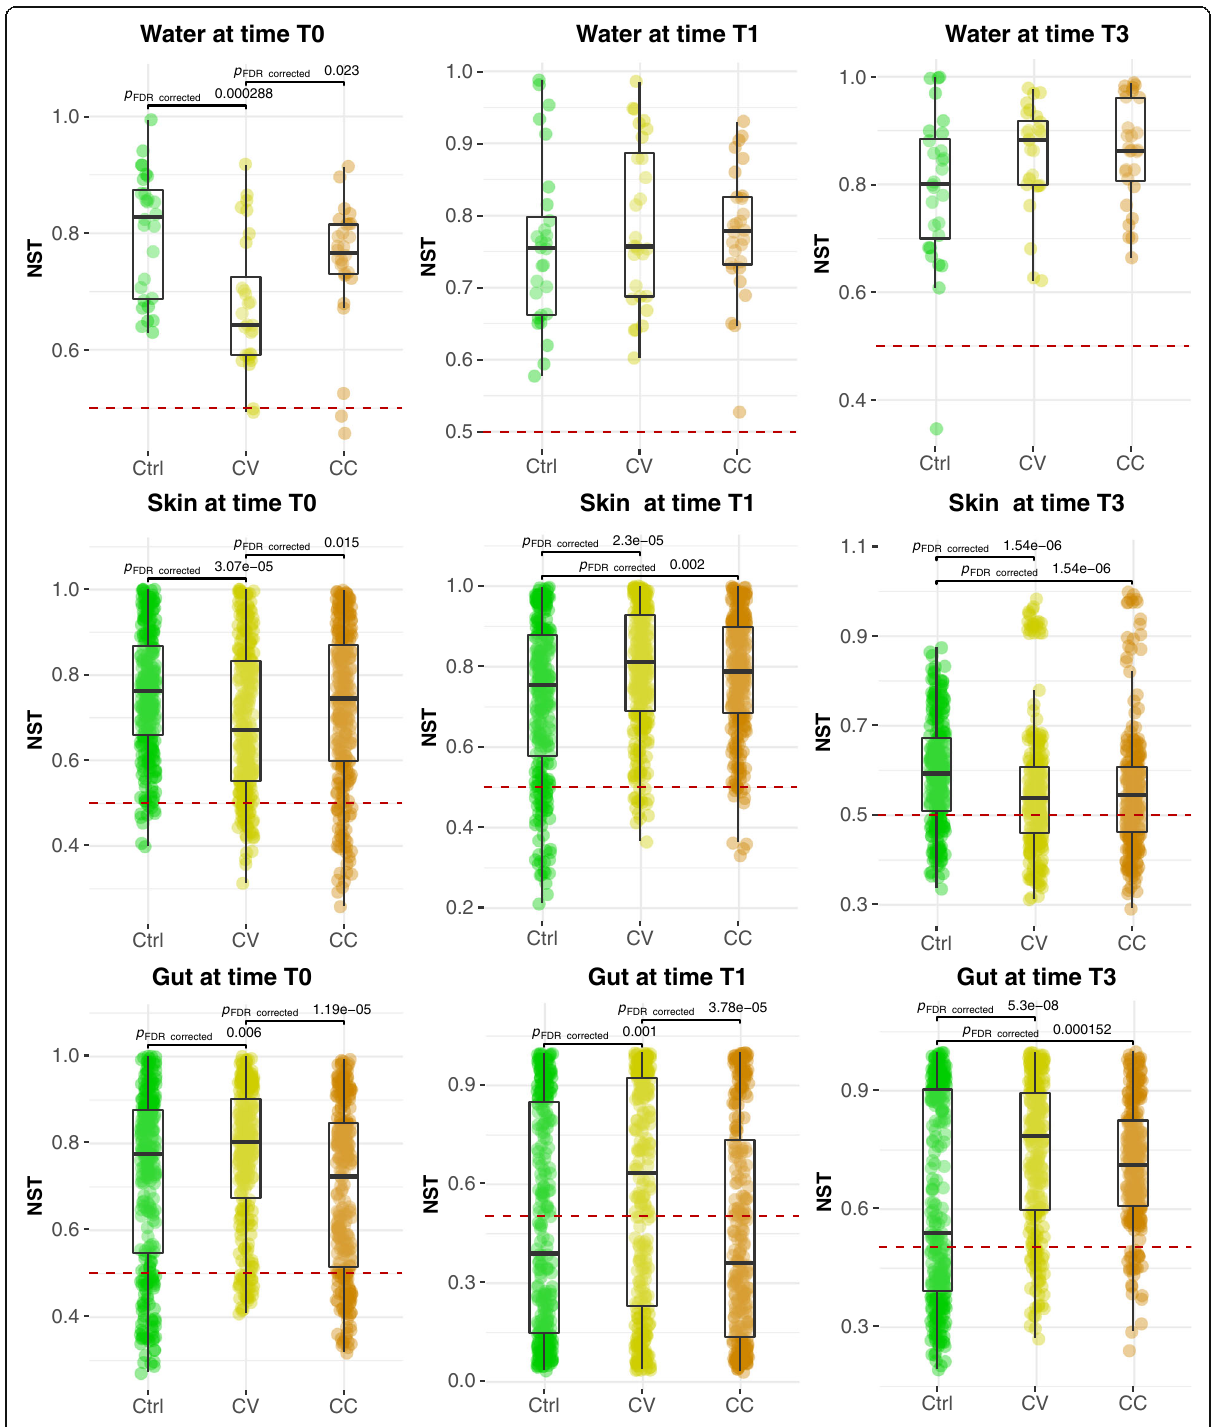
Fig. 7 Comparative analysis of stochasticity ratios averages between treatments. The NST values were computed using the NST model available in the R package. With this model the ” Proportional fixed ” null-model, Jaccard similarity coefficient (also known then as Ruzicka similarity) and n = 1000 for random permutations were used to compute the normalized stochasticity ratios. The NST in each group represented in violin plots were compared for their average using Kruskal-Wallis test followed by Benjamini-Hochberg as a multiple correction test. Only the significant Dunn test p -values for pairwise comparisons are displayed on this figure, however in order to improve visibility, the significant p -values of Kruskal- wallis test for multiple groups comparisons were not